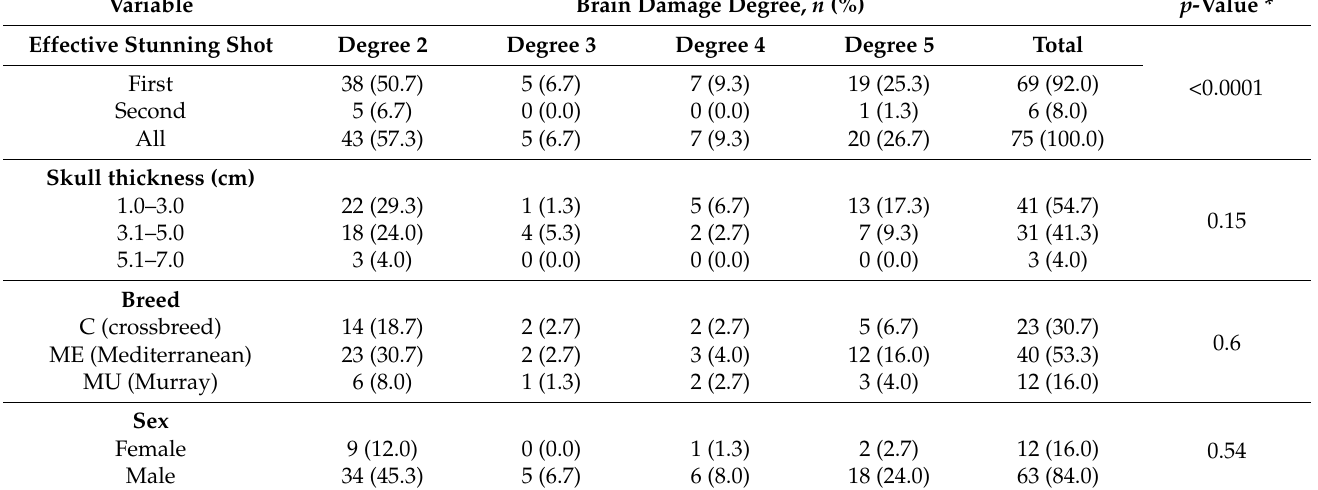
Table 2. Brain damage degree for an effective stunning procedure using a Pneumatic Penetrating Captive Bolt (PPCB) according to the number of shots, skull thickness, breed, and sex in 75 buffaloes during phase